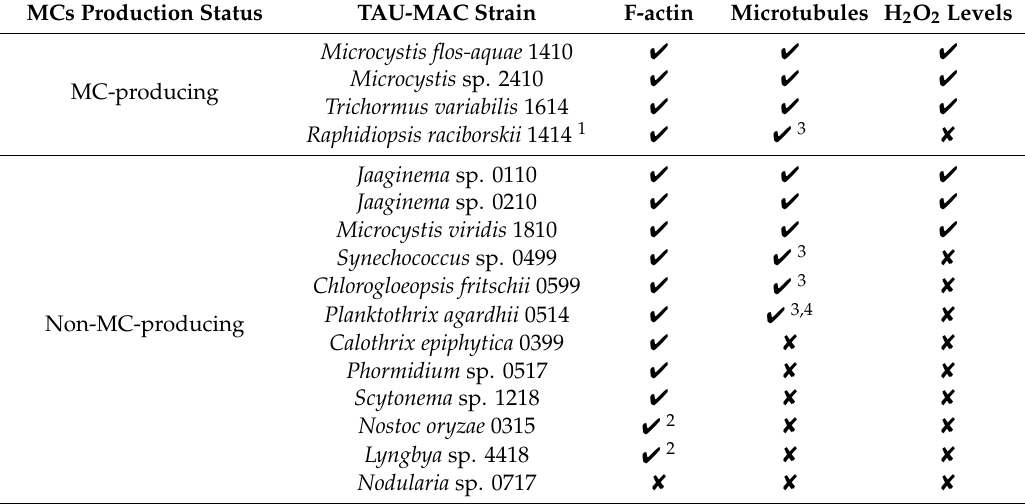
Table 2. E ff ects observed in rice root cells after exposure to cyanobacterial extracts, with reference to each strain. “ (cid:52) ”: a ff ected; “ (cid:56) ”: no e ff ect. MCs Production